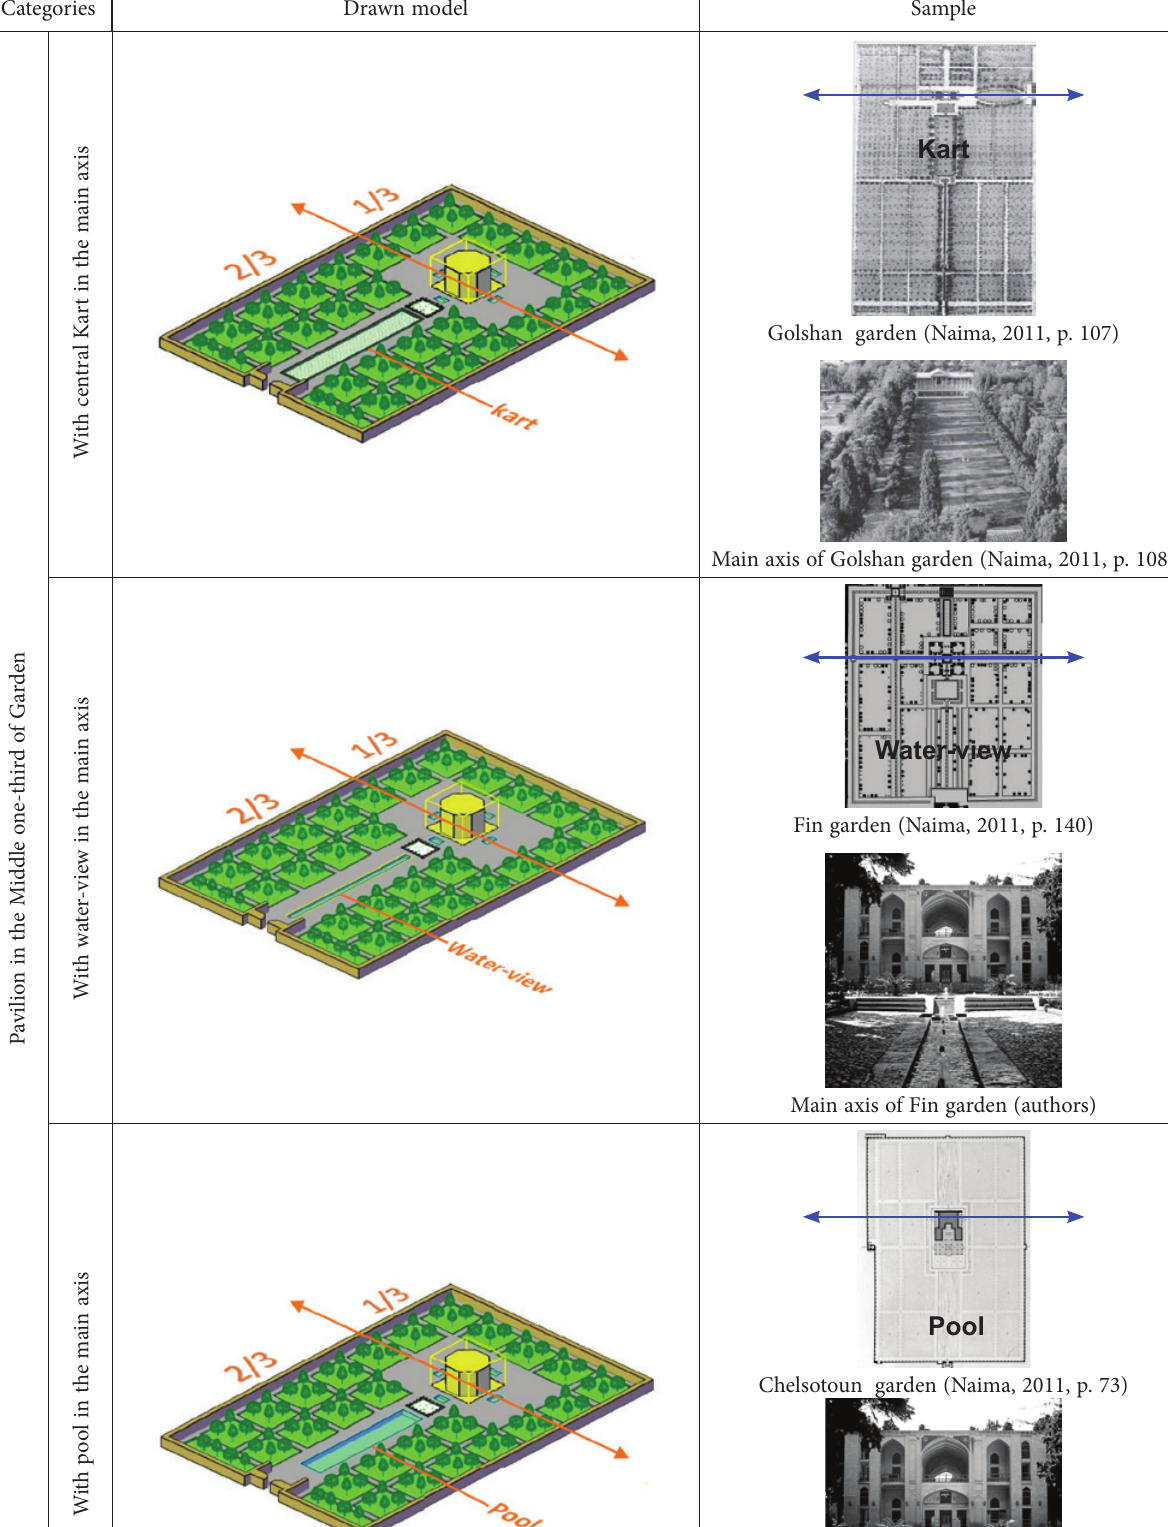
Table 3. Pavilion in the middle one-third of